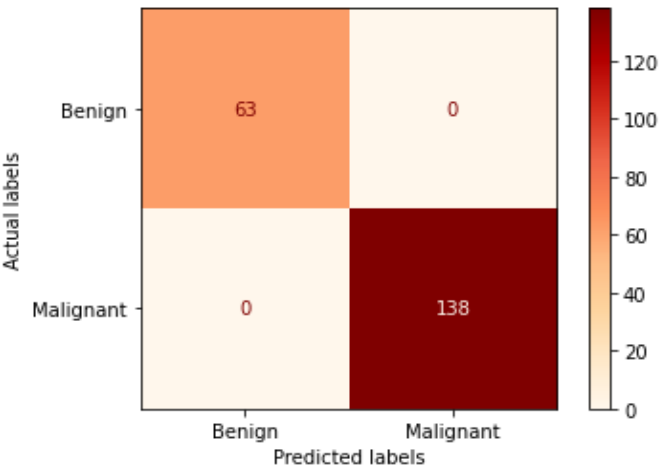
Figure 14. Confusion matrix of VGG19 model in 40 × magnification-dependent binary classification.